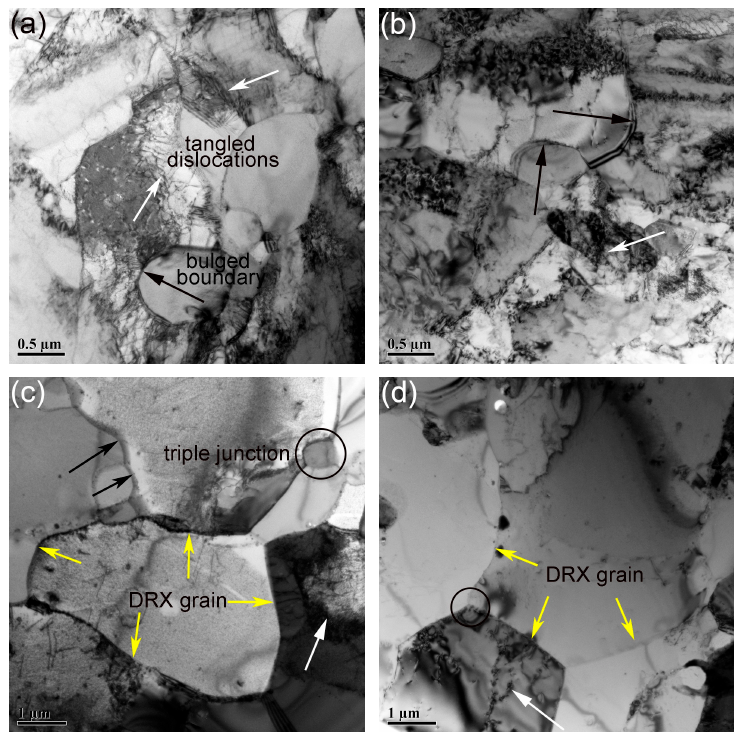
Figure 11. Substructures in the samples deformed at 1200 °C with strain rate of ( a ) 1 s − 1 ; ( b ) 0.1 s − 1 ; ( c ) 0.01 s − 1 ; ( d ) 0.001 s − 1 .